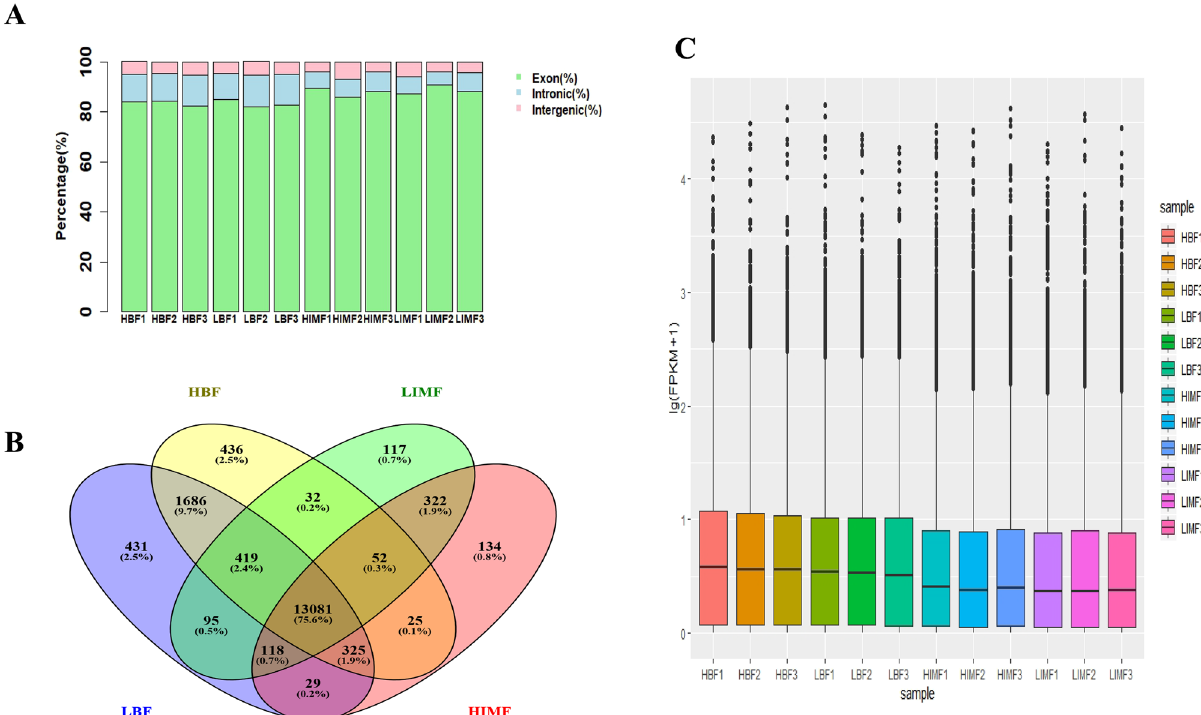
Figure 1. Comparison of sequencing reads and distribution of positively expressed genes. ( A ) The distribution of sequencing reads in the reference genome. The distribution of reads in the exons (green), introns (blue), and intergenic regions (pink) are shown. ( B ) Venn diagrams of expressed genes in the four groups of pigs: LBF, low backfat thickness; HBF, high backfat thickness; HIMF, high intramuscular fat; LIMF, low intramuscular fat. ( C ) Distributions of expression values of 12 samples. The boxplots show log 10 (FPKM + 1) values of each gene from the 6 sets of RNA-Seq data. The black lines in the boxes represent the